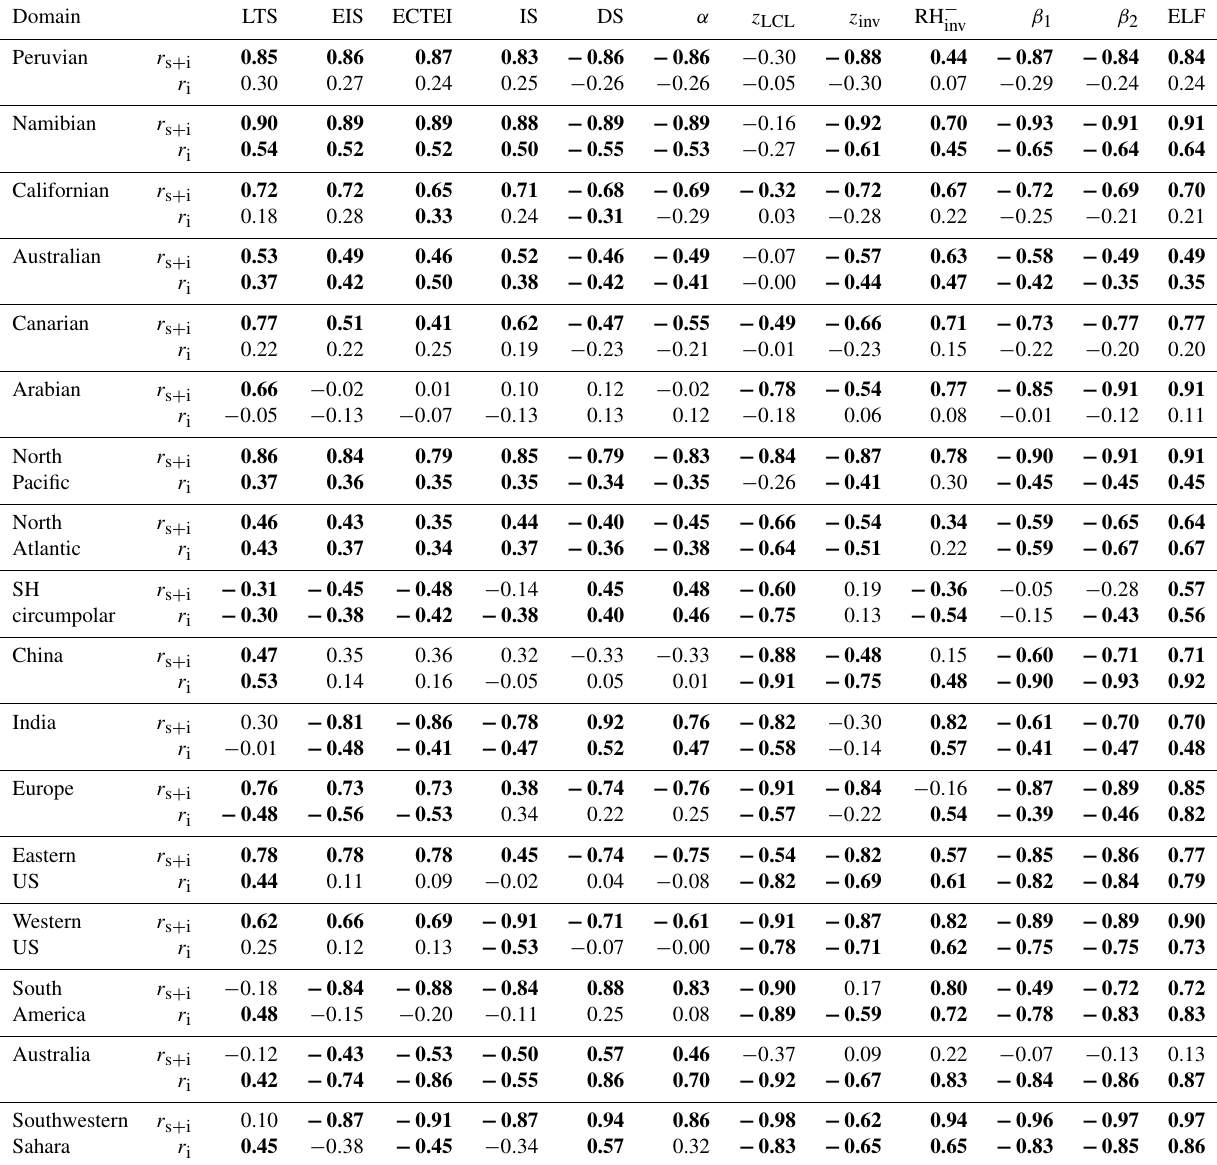
Table 5. The same as Table 2, but all data (i.e., 0 < α < 1 and α = 0 and α = 1) are used for this table.